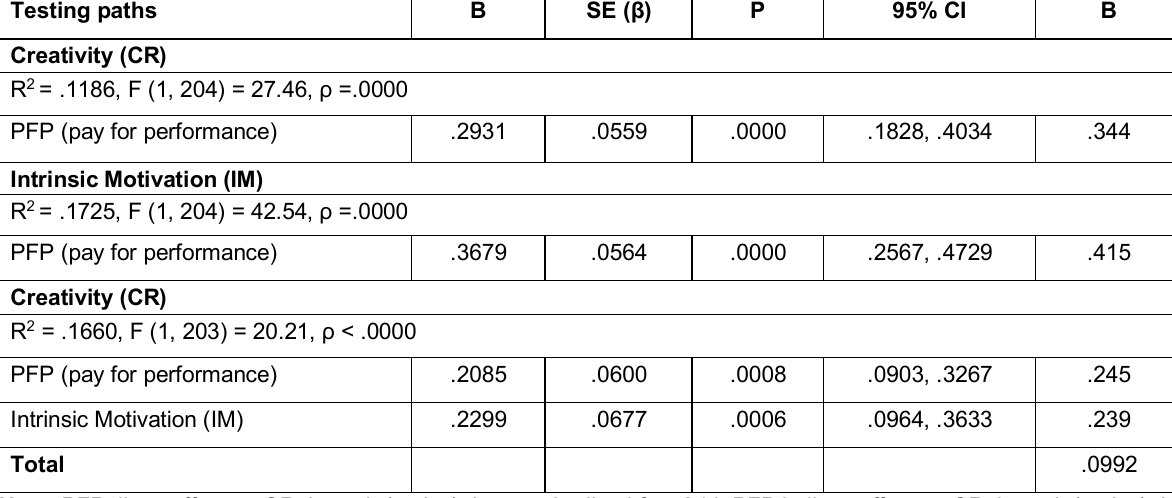
Table 2: Coefficients for the mediating